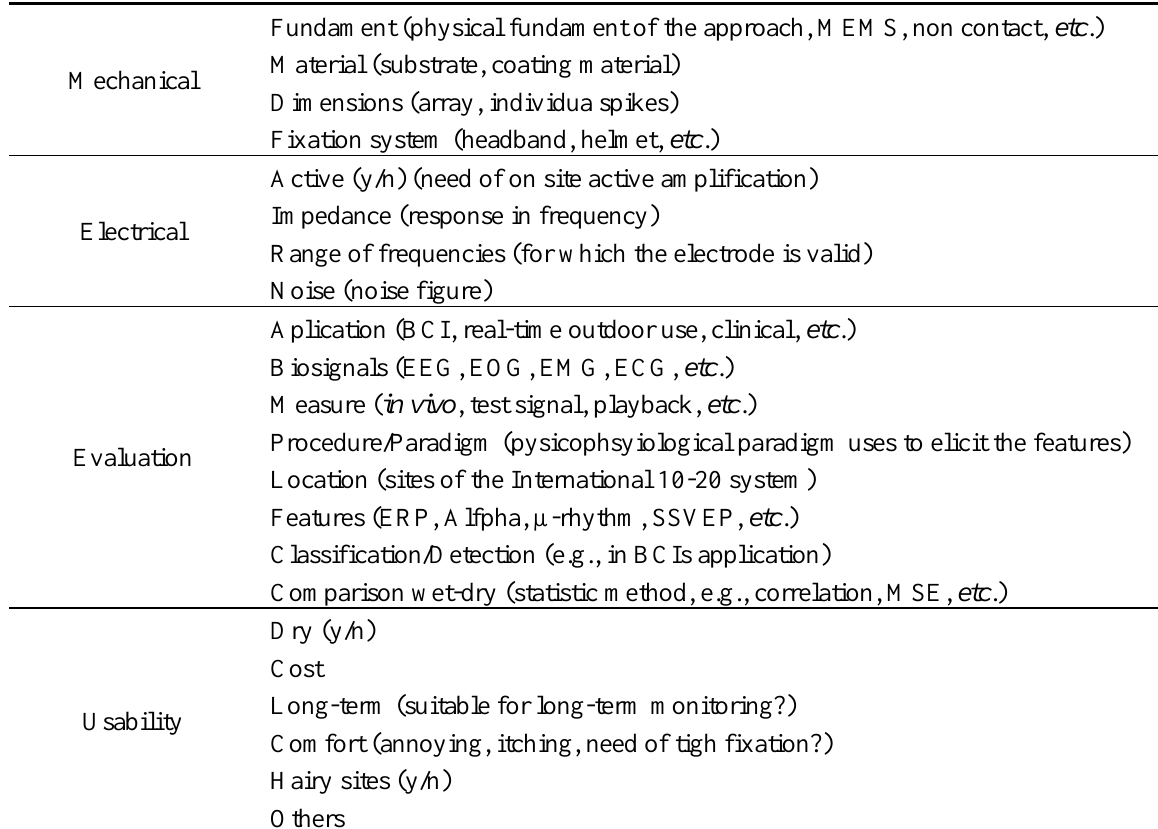
Table 3. Description and evaluation of dry EEG